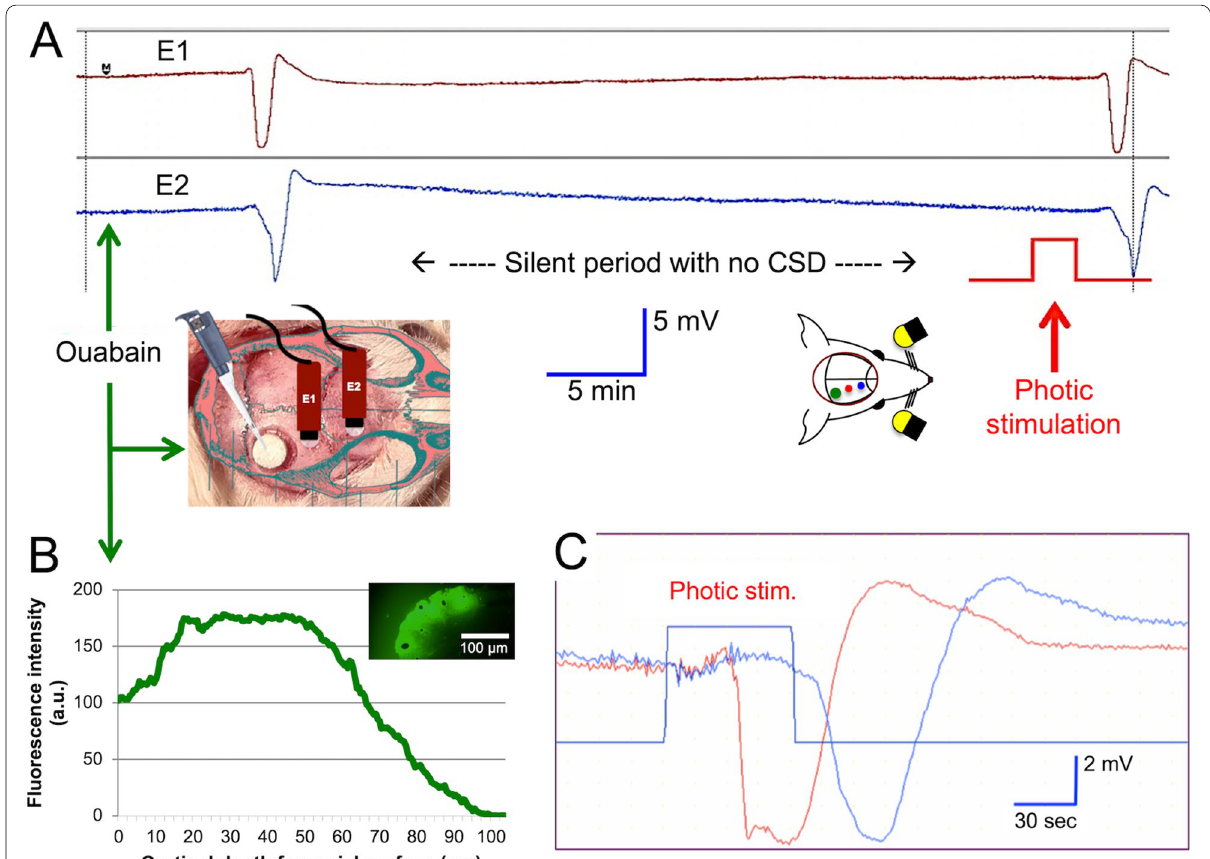
fig. 1 Photic stimulation evokes CSD in the visual cortex primed with around‑the threshold dose of ouabain. A shows the DC potential recordings from 2 extracranial electrodes placed 1 mm apart anterior to the cranial window opened over the occipital cortex. Ouabain (0.1 mM) application over the dura induced a single CSD. After a silent period of 30 min without any CSD, photic stimulation (1 min at 12 Hz) evoked a CSD in this mouse. Below schematics illustrate the placement of electrodes and cranial window over the mouse skull and photic stimulation setup (right). B illustrates that penetration of the fluorescent‑labeled ouabain (BODIPY 0.1 mM, epidural) is limited to the superficial layers of the cortex. C shows another example of CSD evoked with photic stimulation. The distance between CSD generating primed occipital cortex area and recording electrodes causes the latency between the photic stimulation pulse and DC